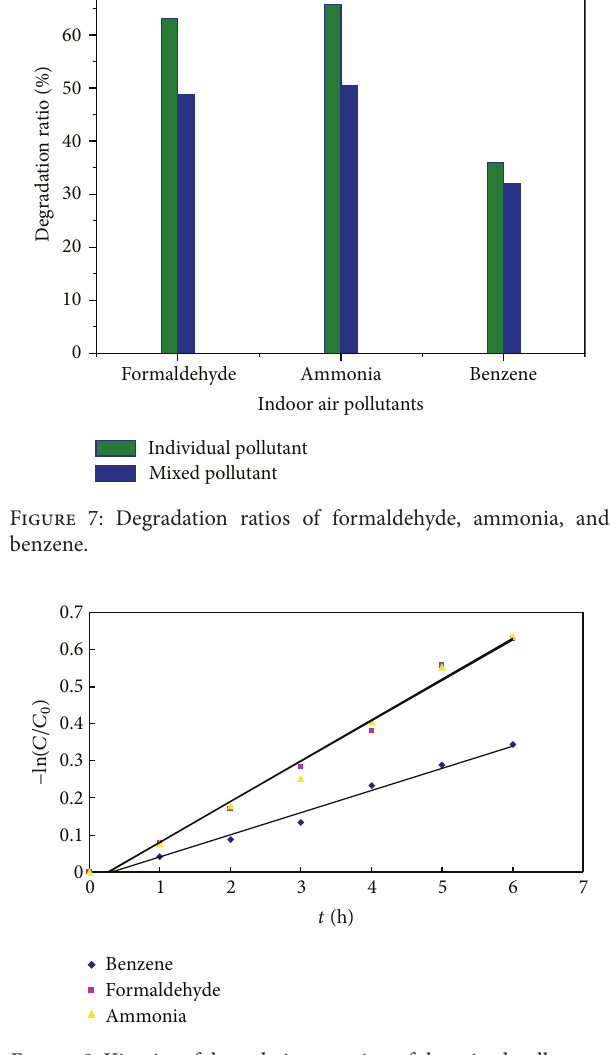
Figure 8: Kinetics of degradation reaction of the mixed